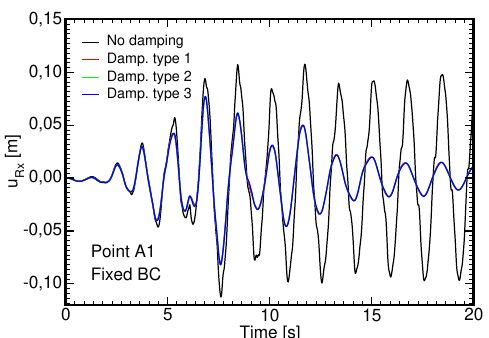
Figure 7. Influence of the type damping - FBB .